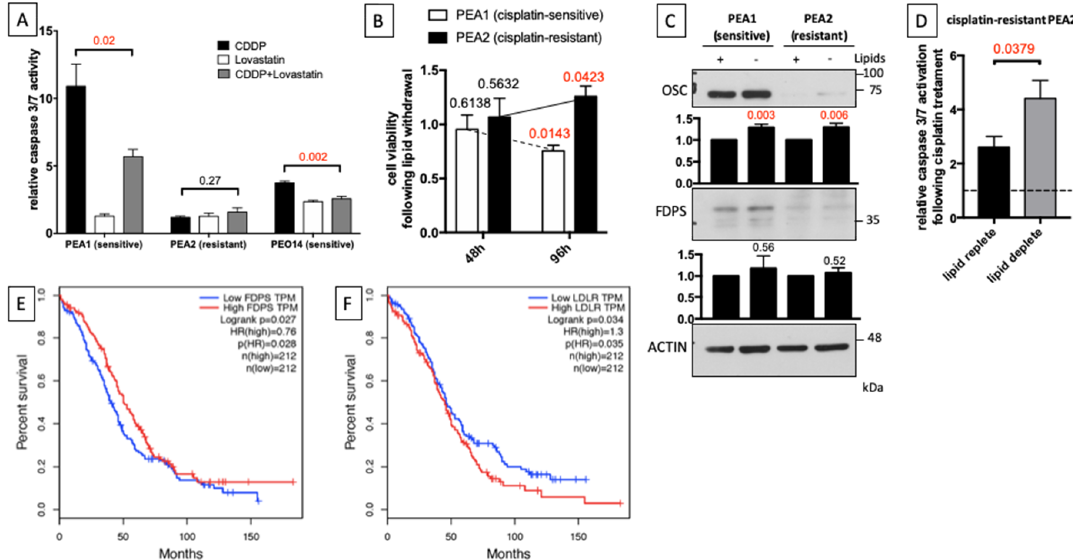
Figure 5. Cholesterol synthesis inhibition increases chemoresistance in platinum-sensitive OC cells. ( a ) PEA1, PEA2, and PEO14 cells were treated with 5 μM Lovastatin and then treated with 20 μM cisplatin for an additional 48 h (when medium was changed, Lovastatin was added again). Subsequently, apoptosis was measured by a luminescent caspase 3/7 activity assay. Data are expressed as mean ± S.E.M. from four (PEA1 and PEA2) or six (PEO14) independent experiments with technical triplicates each. The numbers above the bars indicate the statistical significance ( P -value), based on the two-tailed unpaired Student’s t-test (significant values highlighted in red). ( b ) Twenty-four hours after seeding PEA1 and PEA2 cells in standard culture medium, cells were cultured for additional 48 or 96 h in medium supplemented with lipid-stripped serum. Finally, cell viability was measured by an MTT-based cell viability assay. ( c ) Immunoblot of total lysates from PEA1 and PEA2 cells 48 h after lipid withdrawal from culture medium. Images are representative of five independent experiments. Bar plots below panels show mean ± S.E.M. of relative densitometric band intensity calculated by assuming each band of the control condition (normalized on Actin) = 1 ( n = 5). The numbers above the bars represent the statistical significance ( P -value) based on the Student’s t-test (significant values highlighted in red). ( d ) PEA2 platinum-resistant cells were cultured for 48 h in medium supplemented with lipid-stripped serum and then treated with 40 μM cisplatin for additional 48 h. Apoptosis was measured by a luminescent caspase 3/7 activity assay. Data are expressed as mean ± S.E.M. from four independent experiments with technical triplicates each. The numbers above the bars indicate the statistical significance ( P -value), based on the two-tailed unpaired Student’s t-test. ( e – f ) Kaplan–Meier estimates of the impact of FDPS ( e ) and LDLR ( f ) on overall survival in OC, according to The Cancer Genome Atlas (TCGA) database.